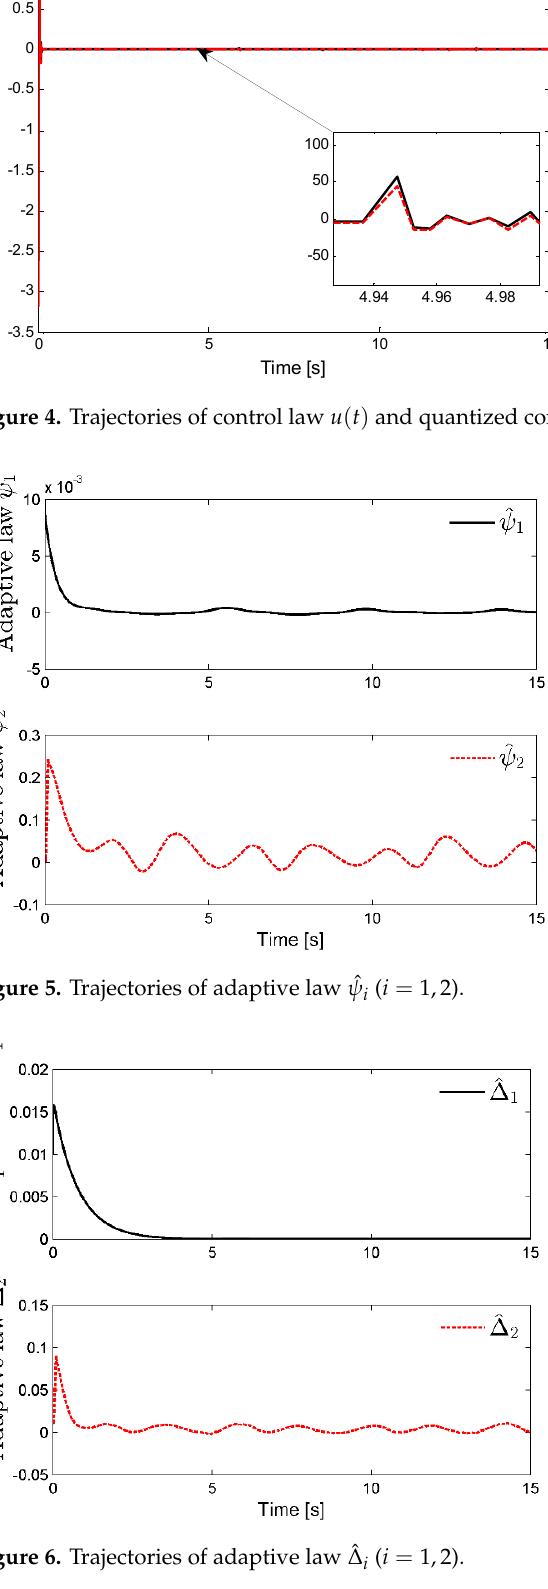
Figure 6. Trajectories of adaptive law ˆ ∆ i ( i =